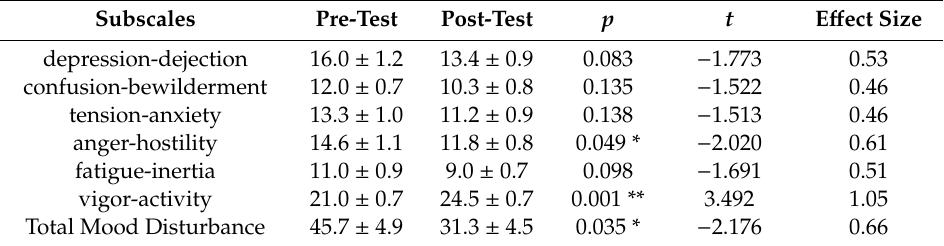
Table 8. E ff ect of Kokedama on Profile of Mood State (POMS).